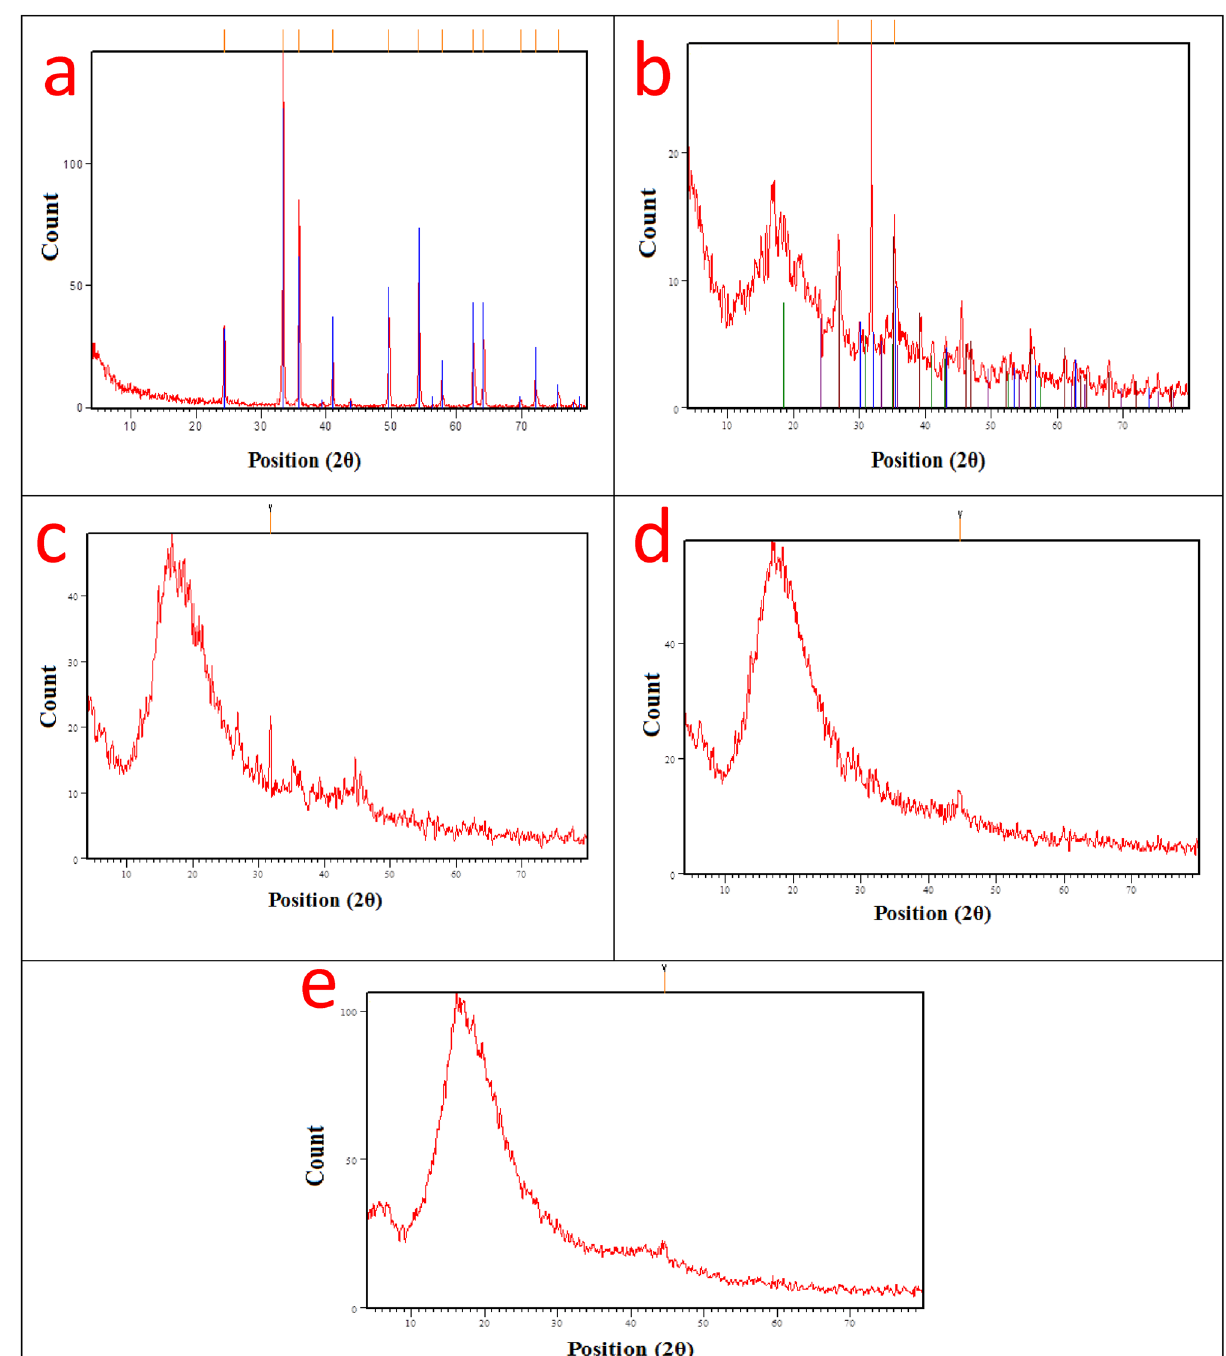
Figure 9. XRD patterns of the checked coating layers ( a ) Unmodified conventional epoxy, ( b ) PA-DGEBA/ MF, ( c ) PA-DGEBA/Bipy, ( d ) PA-DGEBA/MC-Zr and ( e ) PA-DGEBA/MC-Cu after the direct exposure to aggressive salt spray